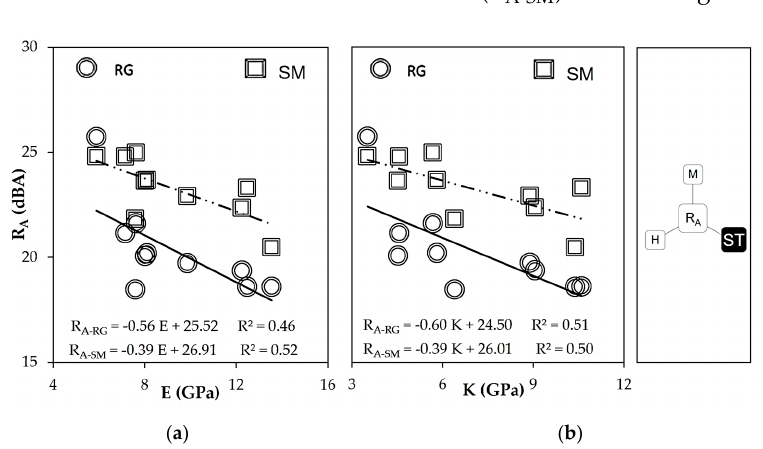
Figure 7. Mechanical parameters related to sound reduction index (R A ): ( a ) Dynamic Young’s modulus (E) ( b ) and bulk modulus (K).